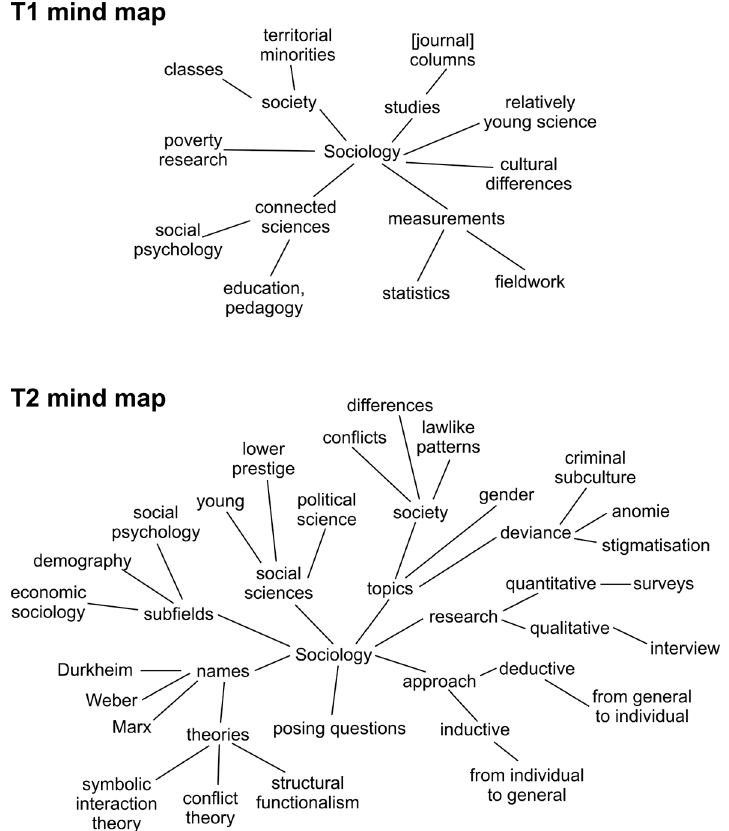
Figure 1. Example of a “deep learning” outcome. T2 shows a broader, more hierarchized structure, with some elements of T1 enriched with new knowledge acquired during the semester.